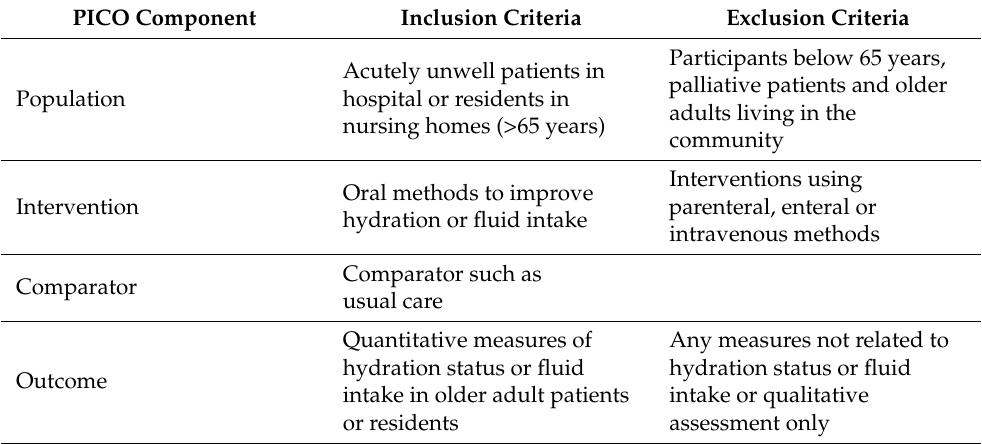
Table 1. Inclusion and exclusion